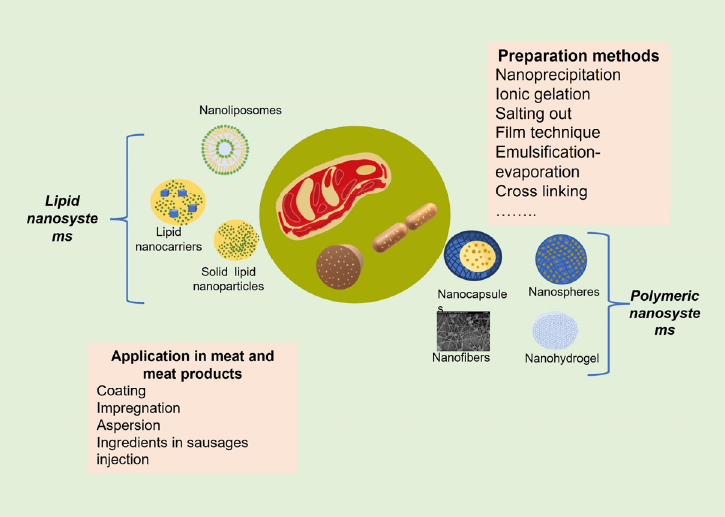
Figure 3. Nanosystems as preservatives in meat and meat